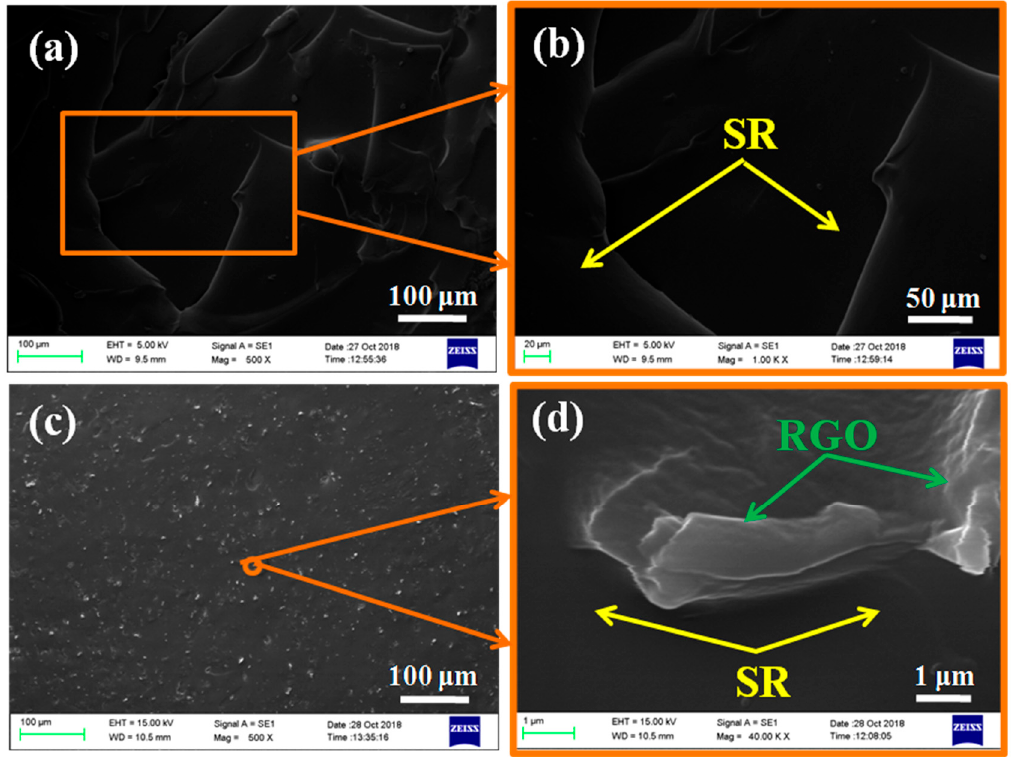
Figure 5. SEM images of ( a , b ) MQ/SR composites and ( c , d ) RGO/MQ/SR composites at different magnifications.